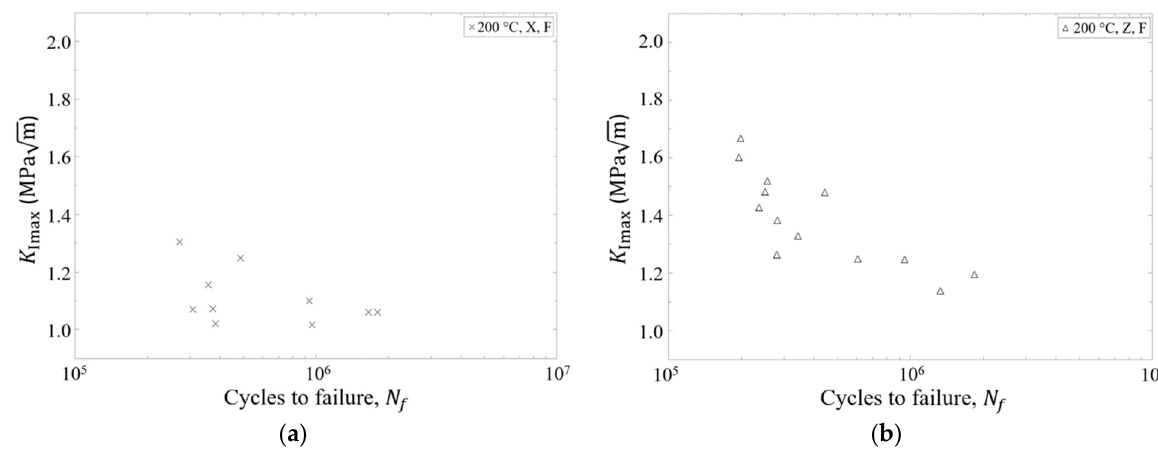
Figure 16. Fatigue results for X ( a ) and Z ( b ) specimens produced on a platform preheated at 200 °C presented in terms of maximum stress intensity factor ( K Imax ) characterizing defects at crack origins and number of cycles to failure ( N f ) for a stress amplitude of 130 MPa.